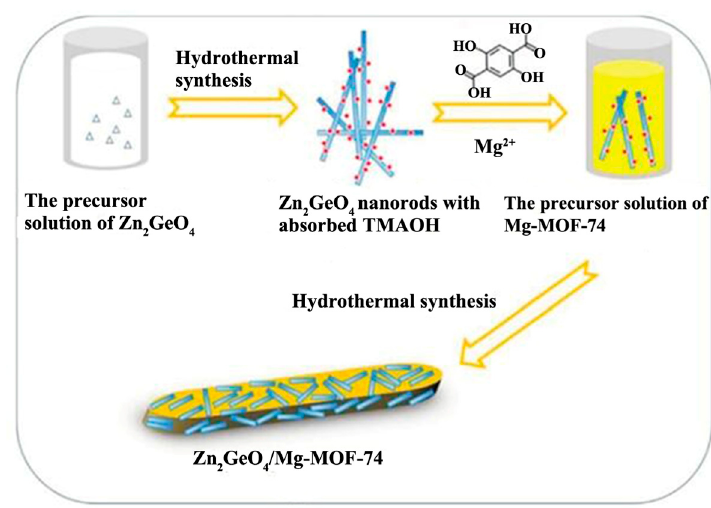
Figure 4. Schematic illustration of the synthesis of the Zn 2 GeO 4 / Mg-MOF-74 composites. Reprinted from ref. 89 with permission by the Royal Society of Chemistry.